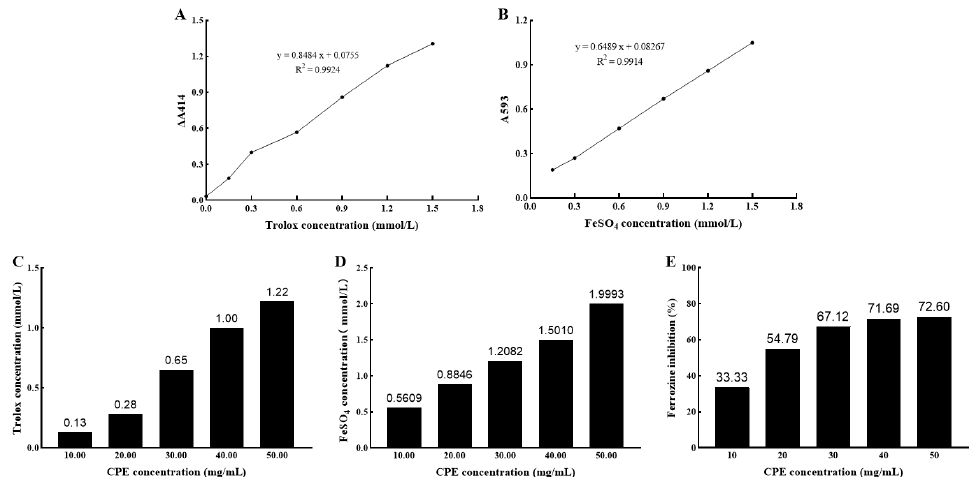
Figure 1. Antioxidant capacity of CPE in vitro. Note: ( A ): Trolox standard curve; ( B ): FeSO 4 standard curve; ( C ): TEAC of 10–50 mg/mL CPE; ( D ): FeSO 4 concentration corresponding to 10–50 mg/mL CPE; ( E ): Metal chelating capacity of 10–50 mg/mL CPE. CPE, cow placenta extract; A, absorbance; ∆ , change; FeSO 4 , ferrous sulfate; TEAC, Trolox-Equivalent antioxidant capacity.